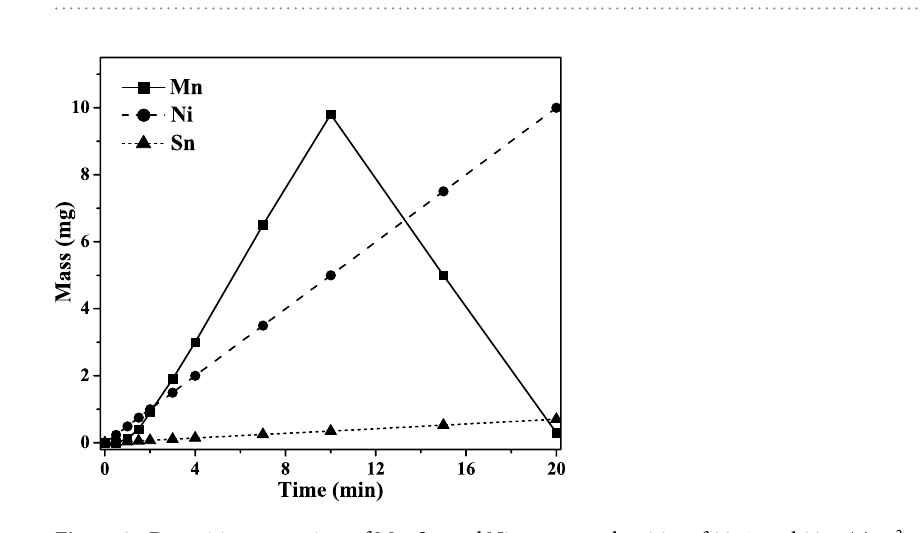
Figure 8. Deposition mass-time of Mn, Sn, and Ni at current densities of 80, 1, and 30 mA/cm 2 , respectively, for a working electrode area of 0.95 cm 2 .